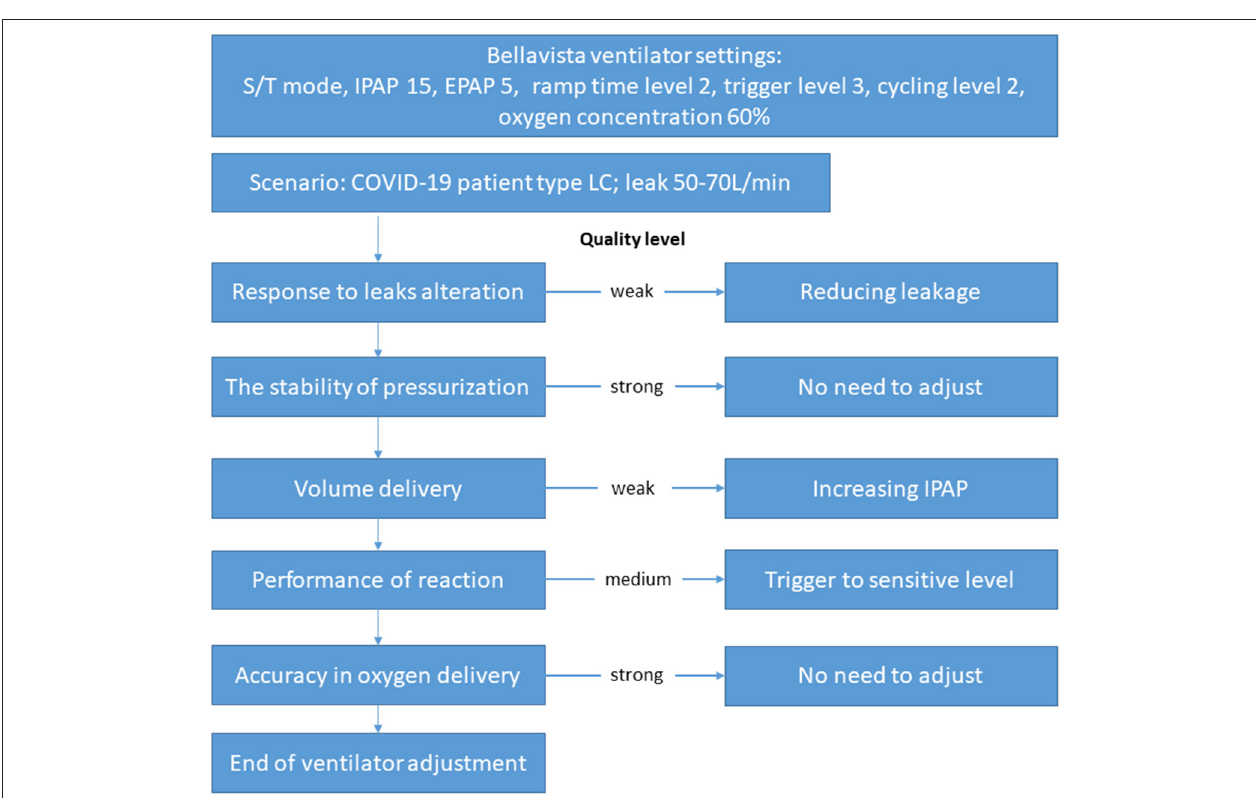
FIGURE 5 | Example on how the findings of the current study could be used in clinical practice. The ventilator Bellavista was used in a patient with lung status similar to the low compliance (LC) model we simulated in the current study. Leakage measured was ∼ 50–70 L/min under the presented ventilator settings. Based on the quality levels we found, the ventilator settings should be adjusted